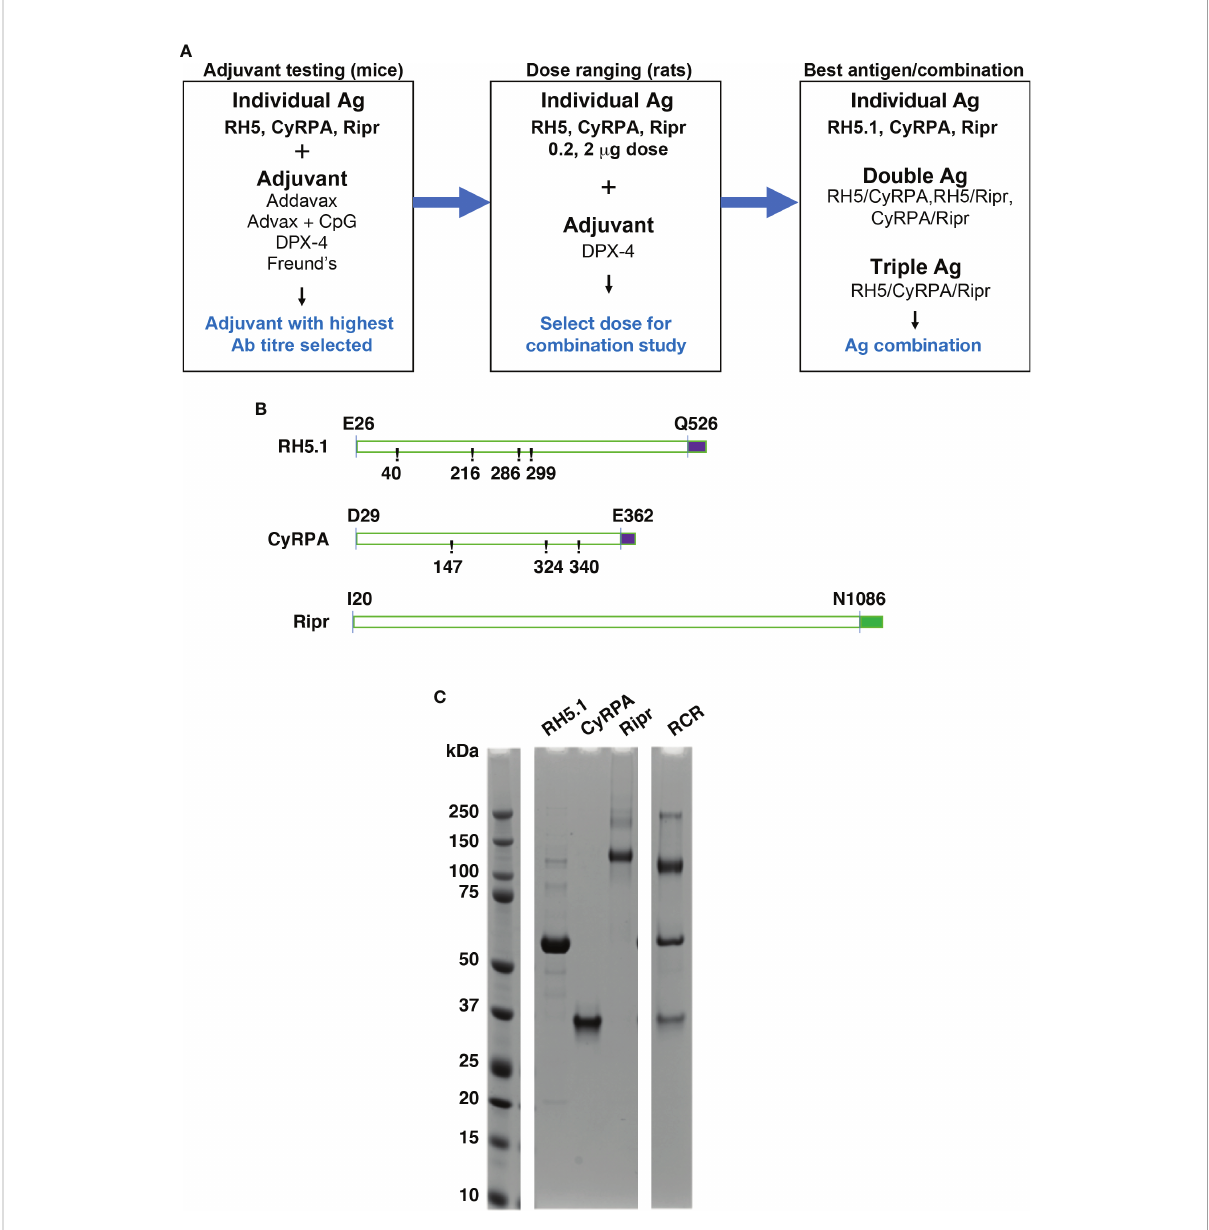
FIGURE 1 Strategy and antigens in the RCR complex used in single, double, and triple combinations to determine immunogenicity and ability to block P. falciparum growth. (A) Work fl ow of experiments to determine immunogenicity and development of growth inhibitory antibodies for the RCR complex. Adjuvants and antigen dose were determined prior to immunisation experiments using combinations of RH5.1, CyRPA and Ripr. (B) Schematic of recombinantly expressed proteins expressed with C-terminal af fi nity tags. RH5.1 (RH5) and CyRPA were expressed with a C-tag (EPEA) (purple) and Ripr was expressed with a StrepII tag (green) for puri fi cation. CyRPA and RH5 sequences were modi fi ed from the 3D7 wildtype sequence (at numbered positions) to remove potential N-linked glycosylation sites. RH5.1 and Ripr were expressed in S2 Drosophila cells, whereas CyRPA was expressed in mammalian HEK293 cells. (C) RH5.1, CyRPA and Ripr and RCR complex puri fi ed antigens analysed by SDS-PAGE and Coomassie staining to visualize the